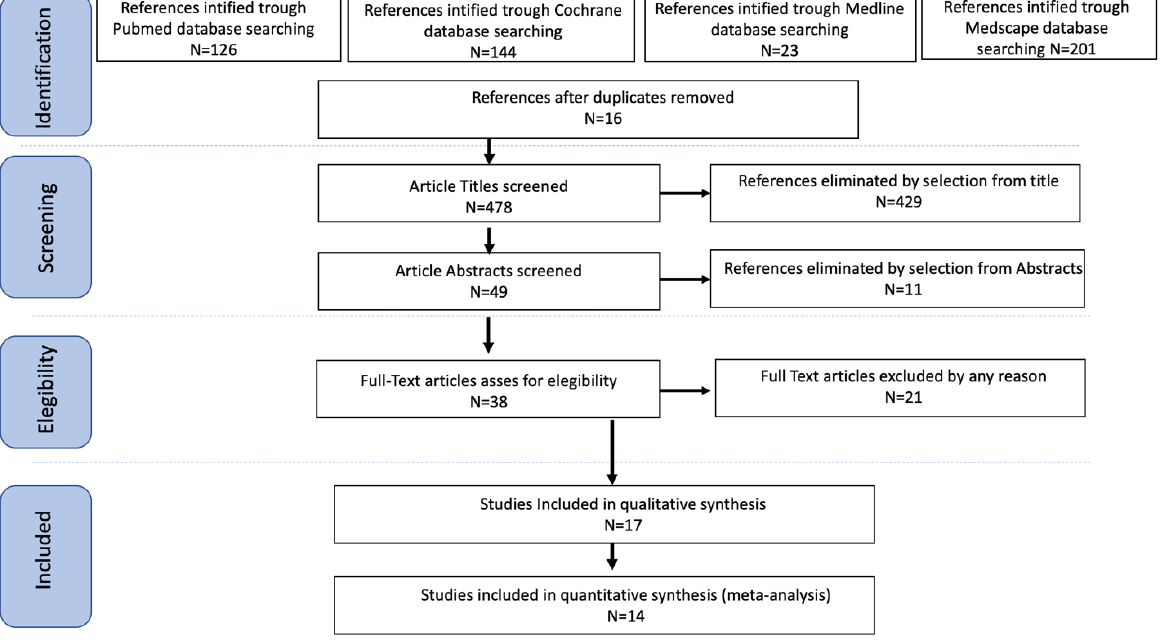
Figure 1. Prisma Flow Chart.